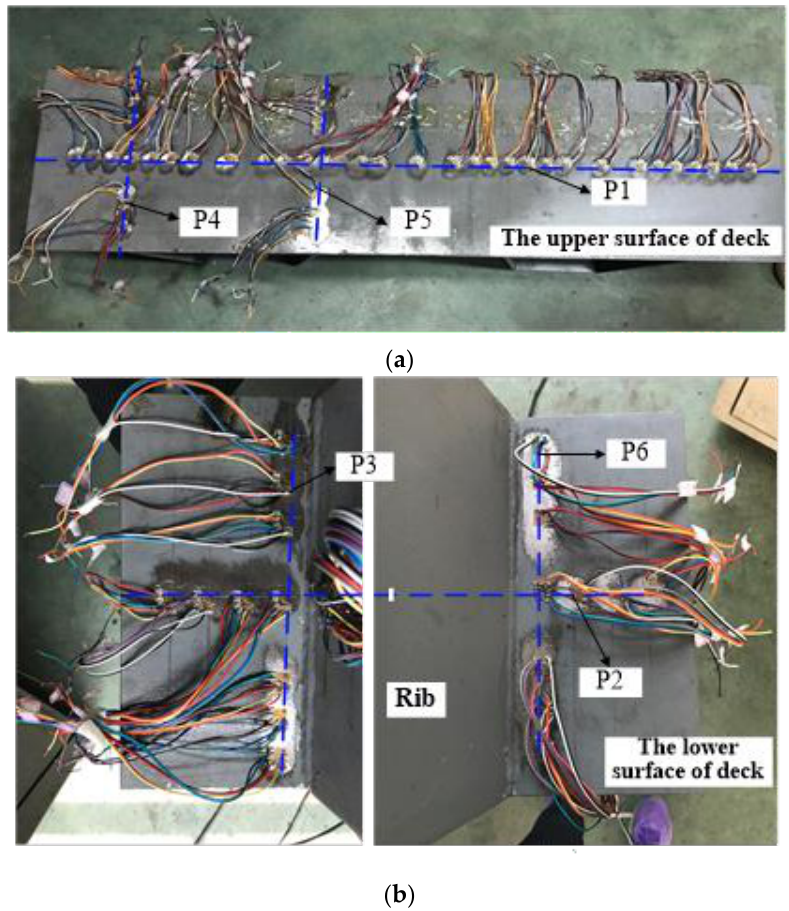
Figure 5. Hole-drilling locations of various paths: ( a ) P1, P4 and P5; ( b ) P2, P3, and P6.